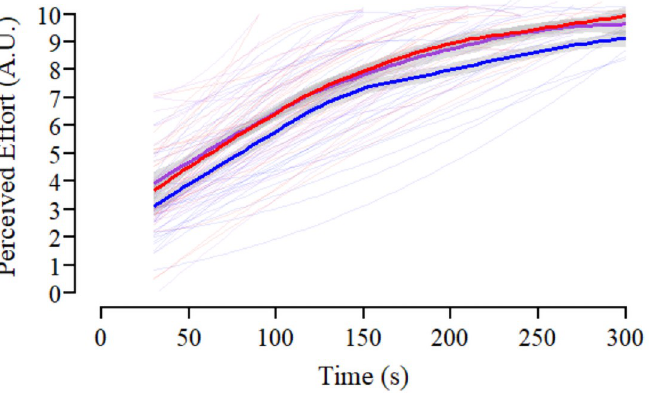
Fig 4. Effect of experimental conditions on perceived effort during the endurance task. Profile of subjective perceived effort responses across the knee extensor (KE) endurance task within the control (CON; blue), moderate RoF (MOD; purple) and severe RoF conditions (SEV; red). Individual responses across time are displayed by smoothed thin lines within each condition. Thick lines represent the change in mean scores over time in each condition, with grey boarders representing 95% confidence intervals.